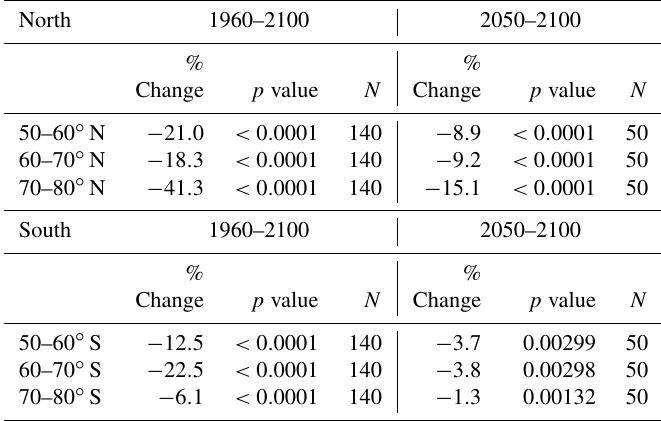
Table C1. Changes in zonal mean surface albedo due to the evolution of GHGs (RCP 6.0) between 5 and 80 ◦ N and 50 and 80 ◦ S, for the periods 1960–2100 and